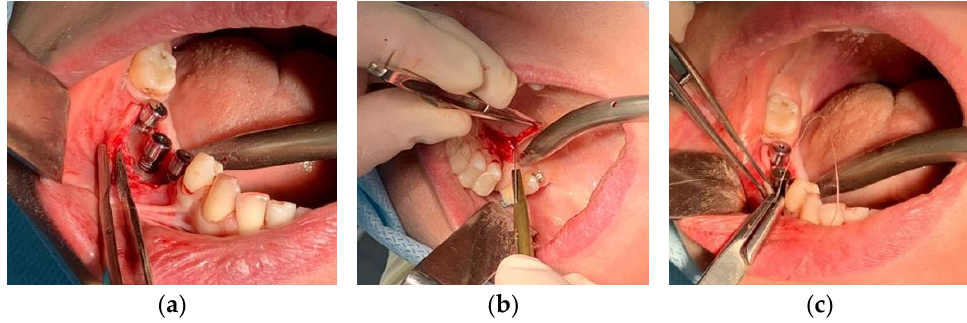
Figure 11. Stages of dental implant surgery according to the classical two-stage method using the Nobel Replace implant system: ( a ) condition of the bone bed in the area of the osseointegrated dental implants at the time of the second surgical stage of dental implantation; ( b ) extraction of the connective tissue graft from the area of the mucous membrane of the alveolar process of the maxilla in the projection of the hard palate; ( c ) soft tissue surgery using a connective tissue graft taken from the region of the hard palate.